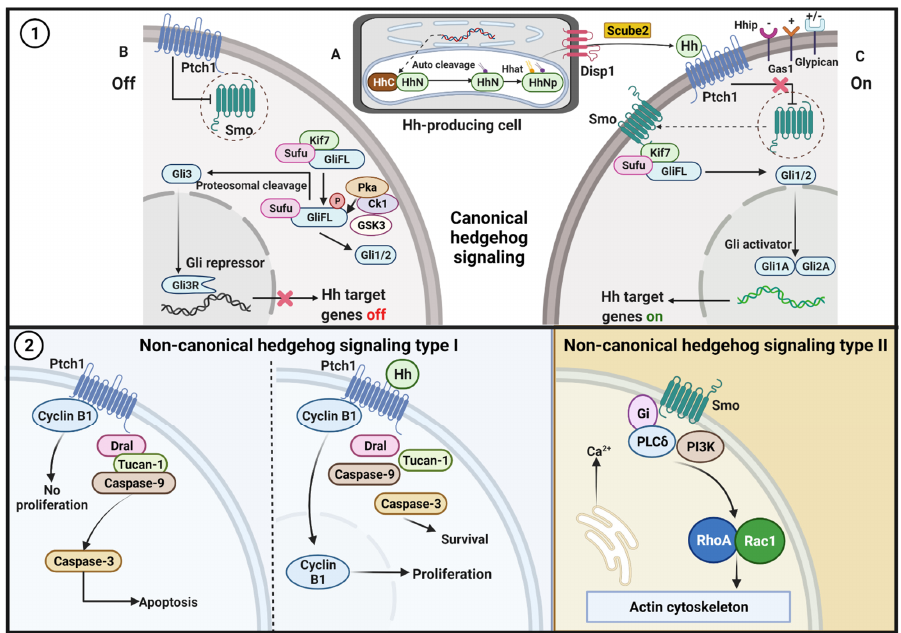
Figure 1. Hh pathway. (1) Canonical signaling. A. The production and secretion of Hh ligands/pro- teins. After translation, the precursor of the Hh protein is transported to the endoplasmic reticulum (ER) for autoclaved and dual-lipid modification. The first modification replaces the C-terminal do- main from Hh-N with cholesterol at the C terminus; then, a palmitate molecule is attached to the N- terminal Hh-N by the Hh acyltransferase (Hhat). Disp1 on the cell surface and Scube2 regulates Hh- N secretion and distribution into the extracellular space of the producing cells. B. In the absence of the Hh ligands, Ptch functions to suppress any inactive Smo that is inside the cell and inhibits the migration of Smo to the membrane. Sufu restrains the GliFL protein in the cytoplasm, and GliFL is then phosphorylated at multiple sites in the C-terminal region by PKA, GSK3, and CK1. Next, the truncated GliR (Gli3) translocates to the nucleus and binds to the Hh target gene (target gene off). C. Ptch1 binds to the Hh ligand and releases the Smo that has been inhibited by Ptch. Active Smo induces the release of GliFL from cytoplasmic retention. The Hh–Ptch1 complex is then internalized and is degraded in the lysosomes. In the end, GliFL is converted to its active form GliA (Gli1 and Gli2) and migrates to the nucleus to activate several target genes (target gene on). Coreceptors for the Hh ligand pathway activate positive regulators (Gas1), negative regulators (Hhip), and dual functions (Glypican). (2) Non-canonical signaling. Type I, in the absence of Hh ligand, Ptch recruits complex proteins Dral, Tucan-1, and caspase-9 that followed by caspase-3 activation, which further amplifies cell apoptosis. The binding of Hh ligand to Ptch disorganizes the interaction of Cyclin B1 and the proapoptotic complex, leading to increased proliferation and survival. Type II, activation of Smo leads to dissociation of Gi, activation of PI3K and RhoA and Rac1, which then modulate the actin cytoskeleton and induce elevation of intracellular